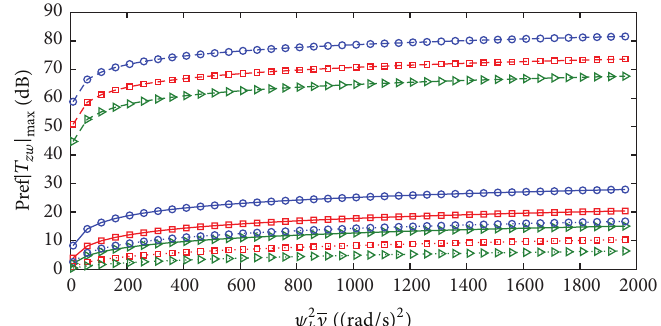
Figure 20: Perf |𝑇 𝑧𝑤 | max as function of 𝜓 2 𝑘 𝛾 . The dashed lines refer to 𝜉 𝑘 The circles identify 𝜔 𝑘